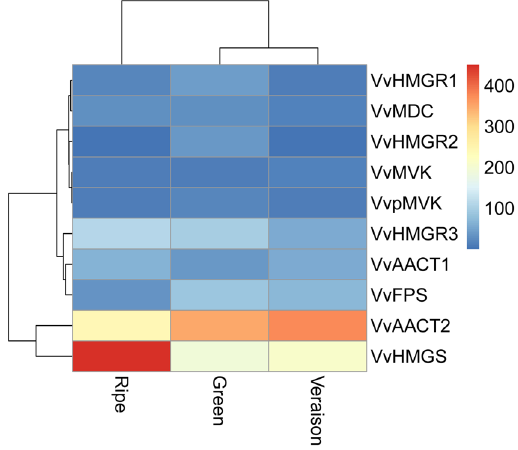
Figrue 5. Expression level of MVA pathway genes during grapevine ripening. Data were obtained by Illumina RNA Sequencing using two biological replicas and are expressed as Reads Per Kilobase of exon model per Million mapped reads